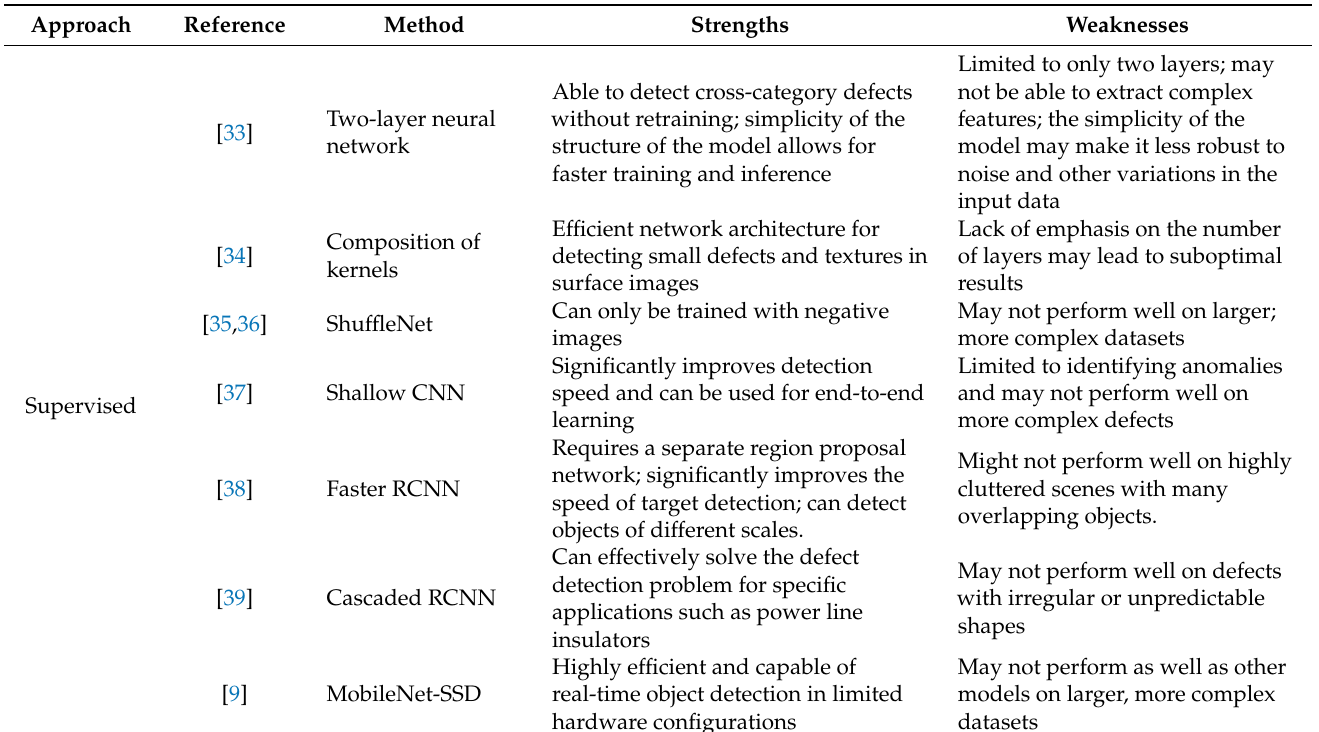
Table 4. Strengths and weaknesses of different techniques for detecting surface defects on industrial products using deep